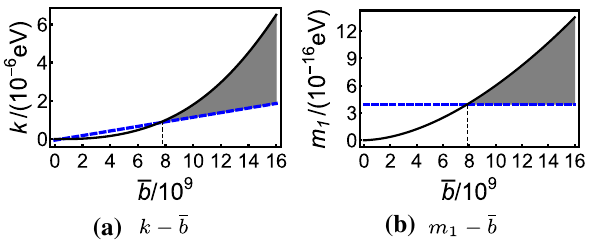
Fig. 4 The limit range of the parameter k and the corresponding range of the first resonance mass m 1 . The shadow region of the left panel is the limit range of the parameter k and the shadow region of the right panel is the corresponding range of the first resonance mass m 1 . The black solid lines are the limits for the lifetime of the first resonance to be longer than the age of the universe and the blue dashed lines are the limits for the five-dimensional fundamental scale M 5 to be greater than 13